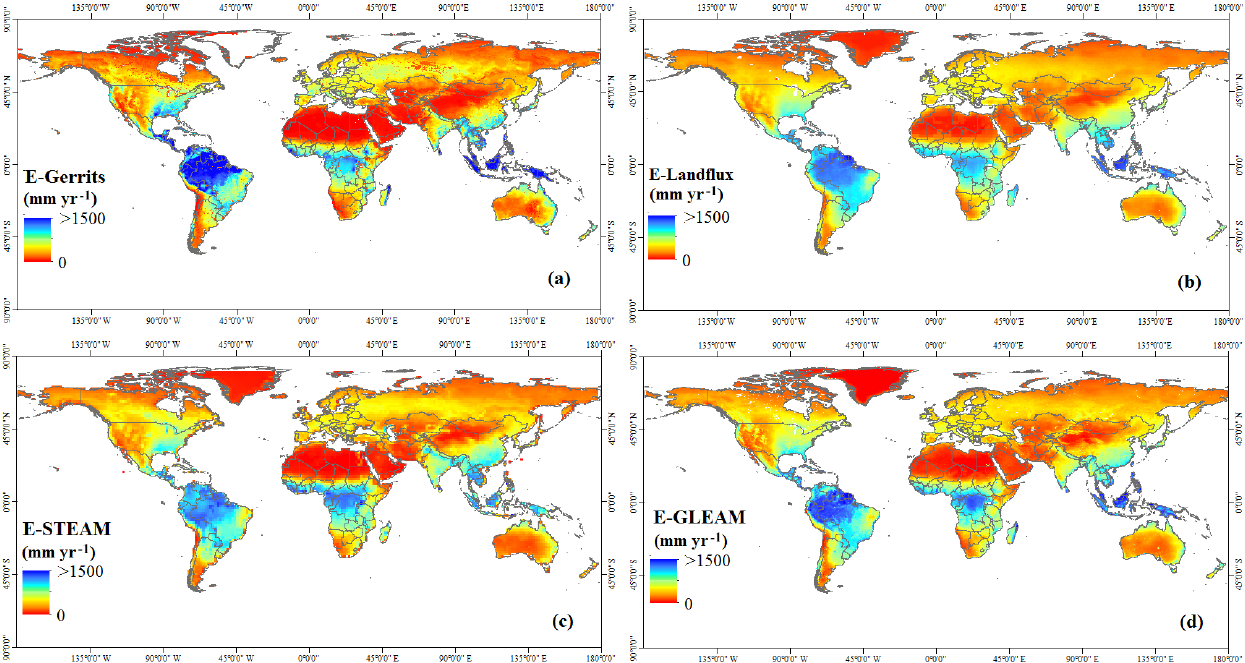
Figure 1. Mean annual evaporation estimated by (a) Gerrits’ model, (b) Landflux-EVAL (Mueller et al., 2013), (c) STEAM (Wang- Erlandsson et al., 2014, 2016), and (d) GLEAM (Martens et al., 2017; Miralles et al.,